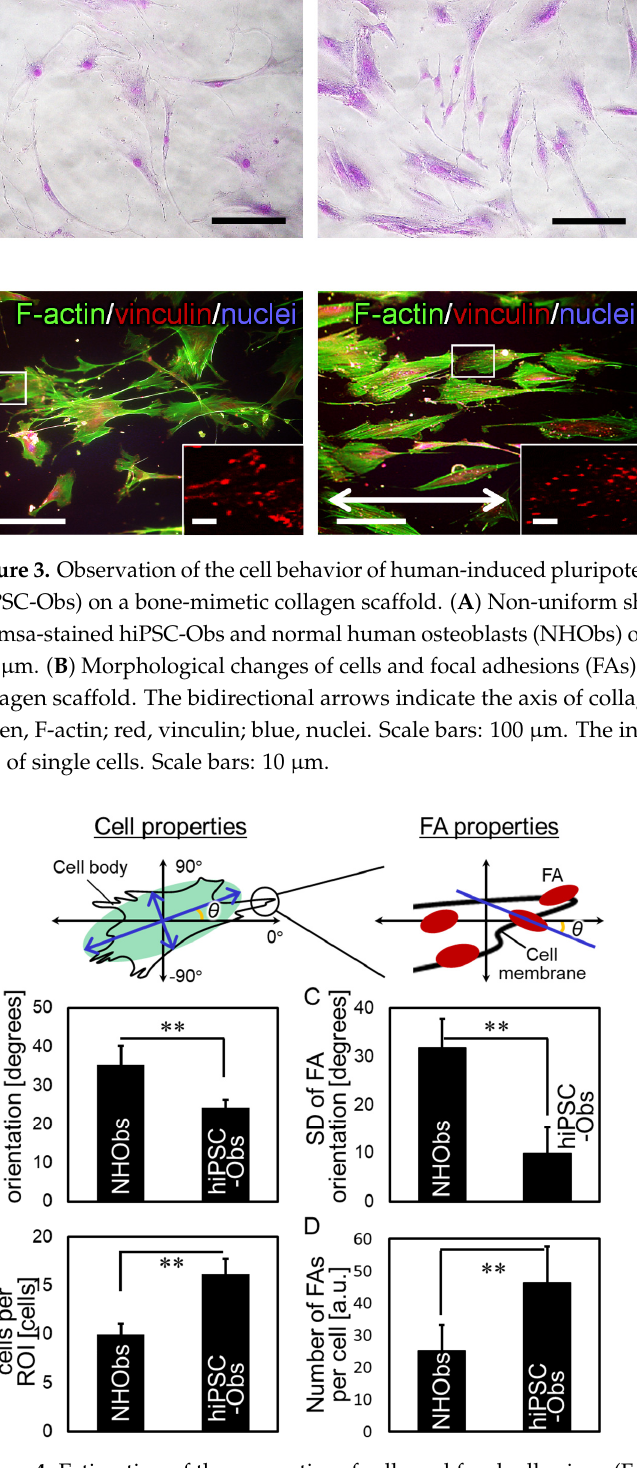
Figure 4. Estimation of the properties of cells and focal adhesions (FAs). The cell properties include: ( A ) the preferential cellular orientation, evaluated using the standard deviation (SD) of the cell orientation angle, and ( B ) cell proliferation, evaluated according to the cell number per region of interest (ROI). The FA properties include: ( C ) the preferential FA orientation, evaluated using the SD of the FA orientation angle, and ( D ) the number of FAs per cell. The data obtained from more than five biological replicates were averaged and are shown as the means ± SDs. ** p <